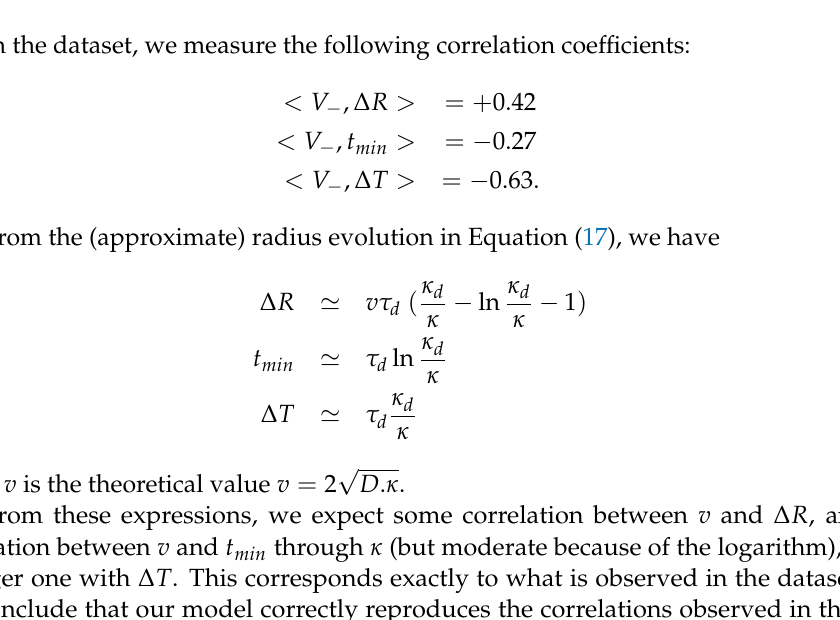
Figure 7. Histograms of the best fit parameters for the velocity parameter ( a ), death characteristic time ( b ), and proliferation ratio ( c ) for our selection of 20